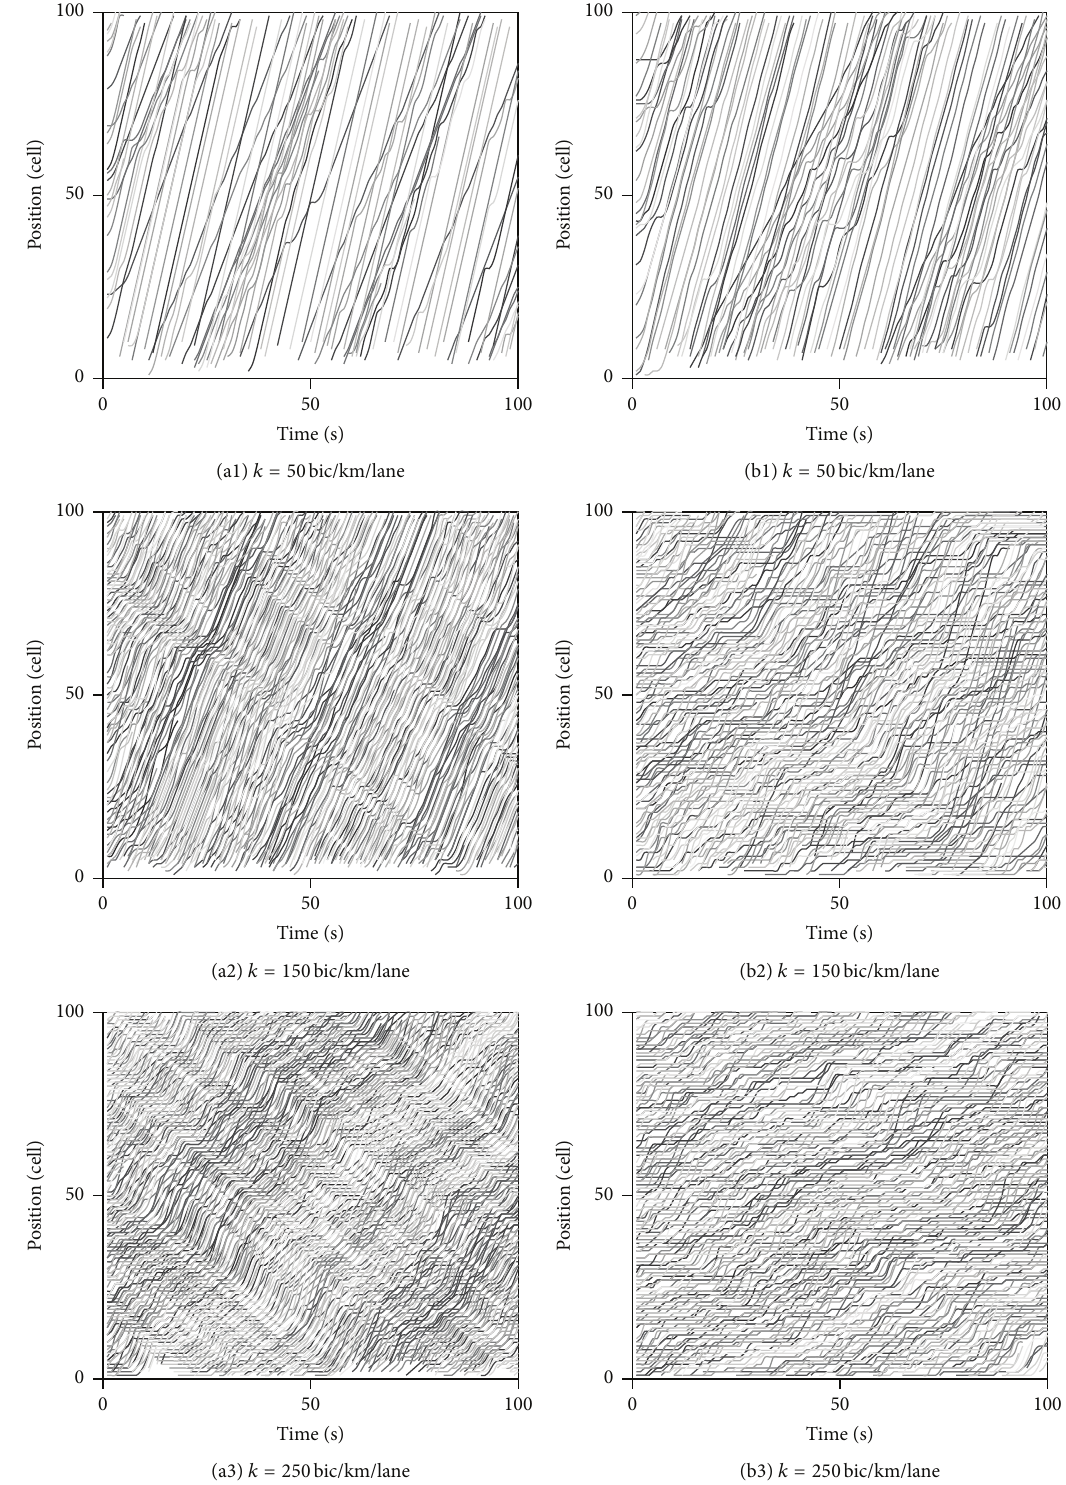
Figure 8: Traffic conditions under different densities: (a) our model; (b) Zhao’s